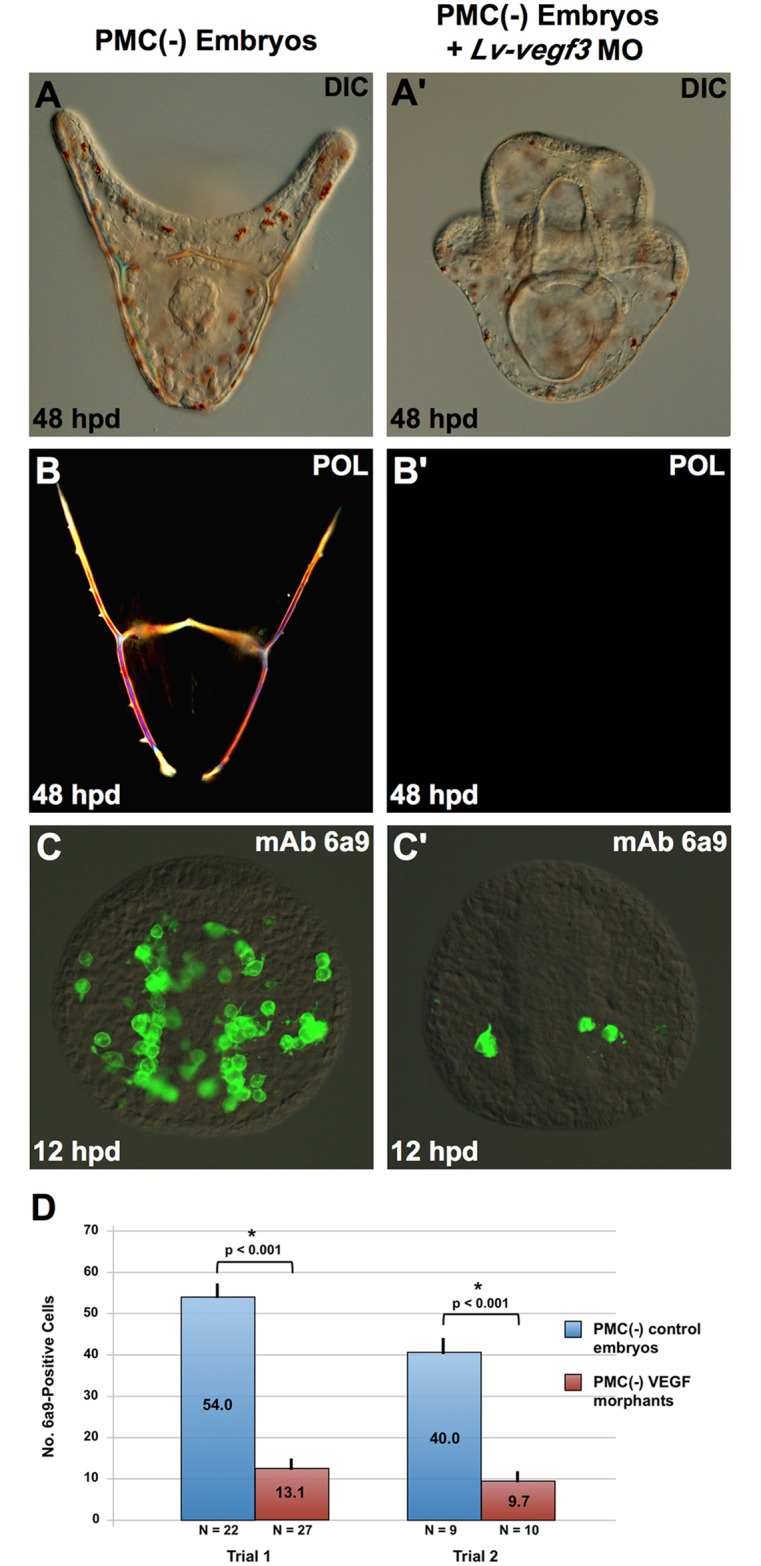
Lv-VEGF3 is required for BC transfating.A previously characterized translation-blocking MO was used to interfere with Lv-vegf3 expression [11]. PMC(−) morphant embryos failed to form skeletal elements even at 48 hpd (A-B’), and very few 6a9(+) cells were detectable at 12 hpd (C-D), indicating that BC transfating was largely blocked. Statistical significance of cell count data was assessed by two-sided t tests, and p-values < 0.05 are indicated by asterisks. Raw data can be found in S1 Data. BC, blastocoelar cell; DIC, differential interference contrast microscopy; hpd, hours post–PMC depletion; Lv-vegf3, L. variegatus vascular endothelial growth factor 3; mAb, monoclonal antibody; MO, morpholino; PMC, primary mesenchyme cell; POL, polarized light microscopy.